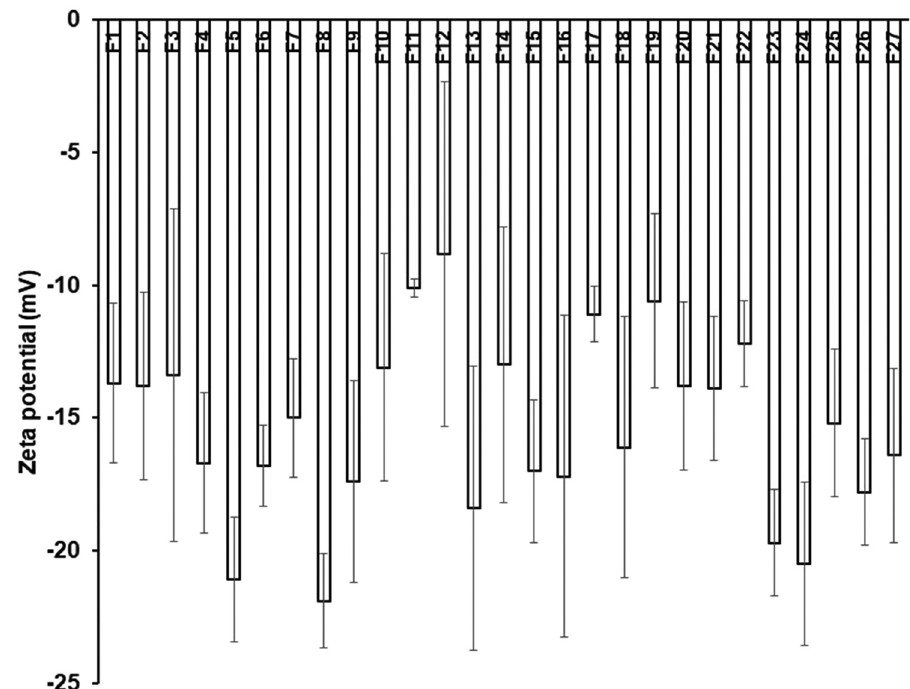
Figure 3: Zeta potential values of di ff erent APG nanoparticle